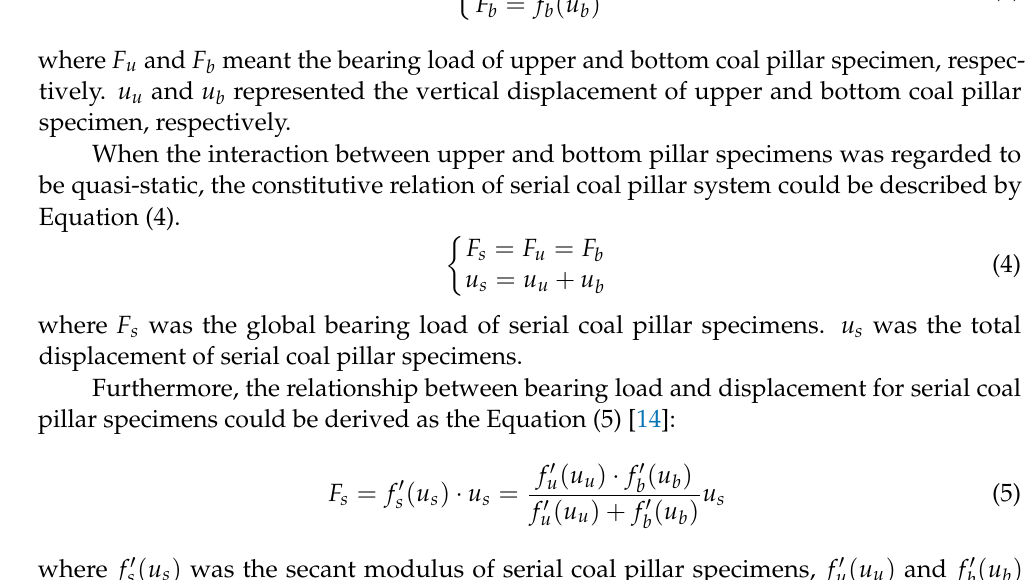
Figure 16. Schematic model of serial coal pillar specimens before and after the uniaxial loading. For the upper and bottom coal pillar specimen, the relationship between the bearing load and displacement could be expressed by Equation (3) [14,21].